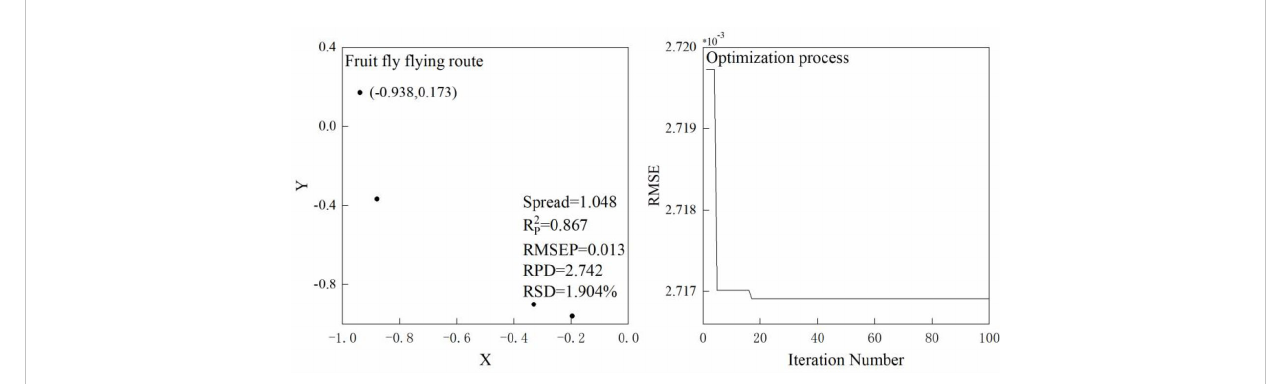
FIGURE 9 The optimization process of FOA-GRNN models for Chinese white poplar (Heilongjiang).